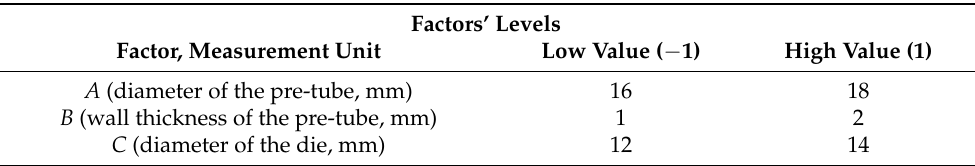
Table 8. General experiment design table for the case of the response variable y 1 (the final outer diameter of the tube)—factors’